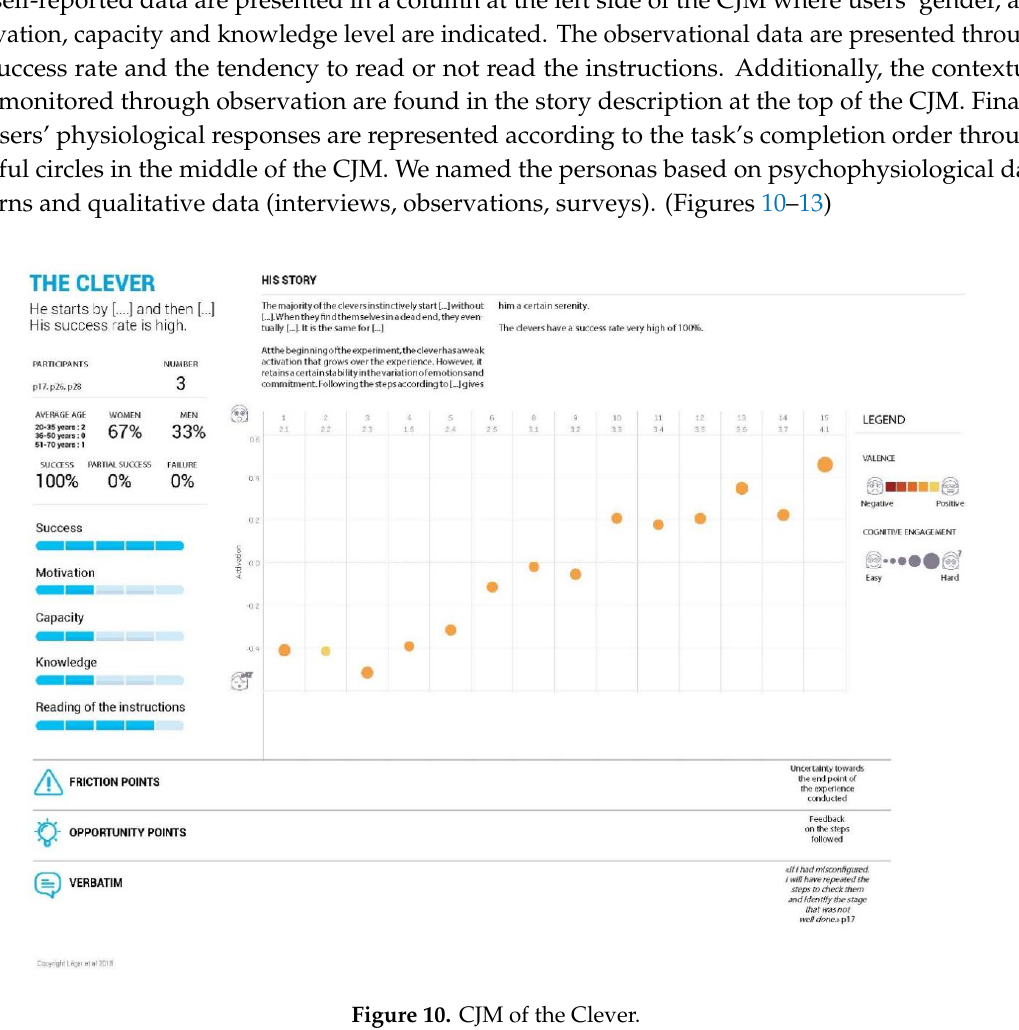
Figure 10. CJM of the Clever.